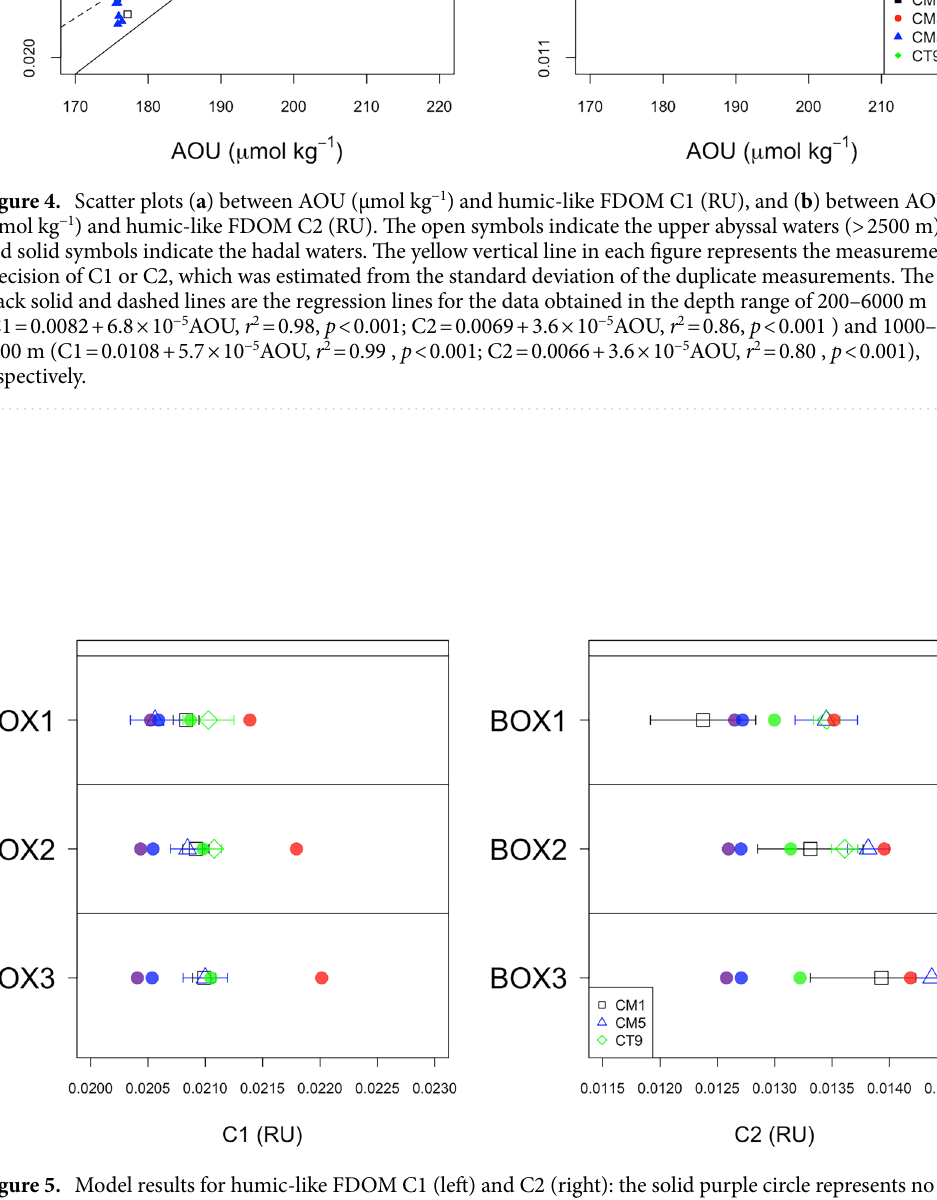
Figure 5. Model results for humic-like FDOM C1 (left) and C2 (right): the solid purple circle represents no flux case, solid blue circle exhibits the low flux case, solid green circles are the mid flux case, and solid red demonstrates the high flux case. The open black square with a horizontal line in each box represents the average value of humic-like FDOM measurements with a standard deviation for CM1, and the open blue triangles and open green diamonds represent CM5 and